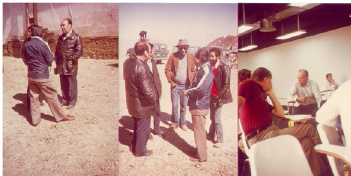
Figure 14. Workshops at LaPaz and Rio de